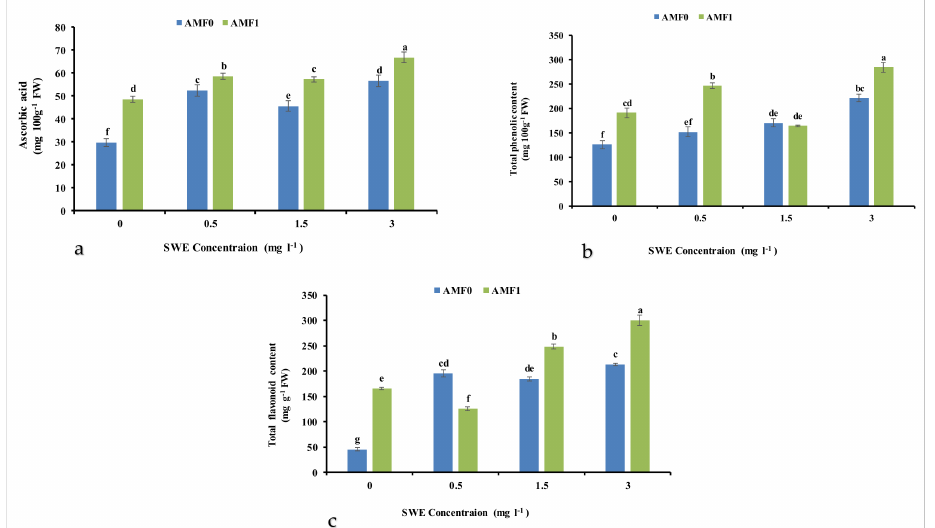
Figure 4. Effect of arbuscular mycorrhiza fungi (AMF) × seaweed extract (SWE) co-treatments on the ascorbic acid content ( a ) total phenolics content ( b ) and total flavonoids content ( c ) of lettuce plants. Different letters indicate significant differences according to the LSD test at p < 0.05. AMF0 and AMF1 refer to without and with arbuscular mycorrhiza fungi,